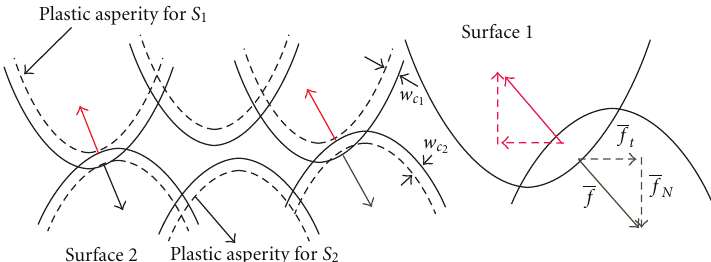
Figure 1: Elastic-plastic contact of two rough surfaces-for w c 2 < w c 1 , elastic-plastic behavior would be dominated by the Surface